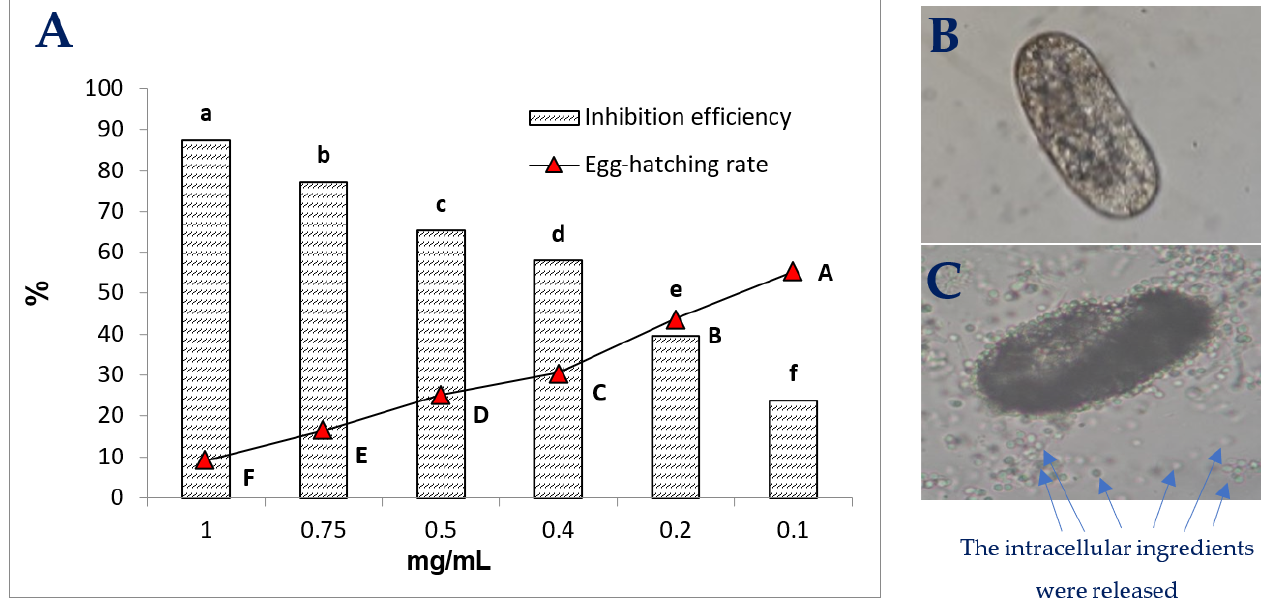
Figure 8. The egg-hatching inhibition of purified prodigiosin. The egg-hatching inhibition (%) of purified prodigiosin ( A ). The experiments were conducted in triplicate and data were analyzed via the simple variance (ANOVA) then Duncan’s multiple range tests at p = 0.01 were performed. Values with the different letters in the same column/line) are significantly different. The value of LSD (Least Significant Difference), CV (Coefficient of Variation) for Inhibition efficiency (%) were 2.5123; 1.657060, respectively and those of egg-hatching rate (%) was 1.7747, and 2.279696, respectively. The graph bio-activity was constructed by Microsoft Excel 2010. The normal nematode egg ( B ) with the membrane around was treated with prodigiosin. After 3 days of treatment, the membrane of the nematode egg was decomposed and released the intracellular ingredients ( C ).